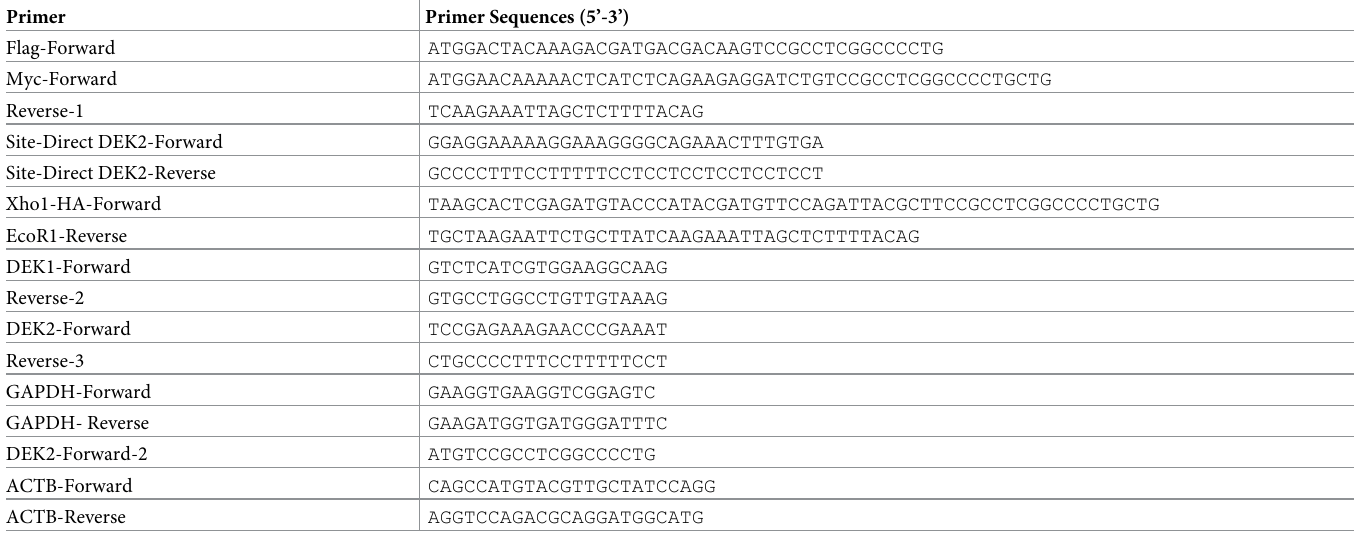
Table 1. List of used